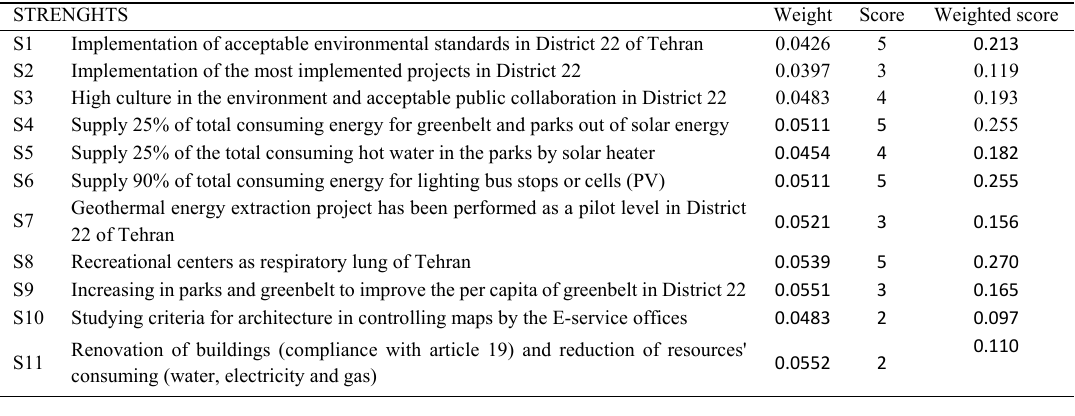
Table 2: Internal factor evaluation matrix